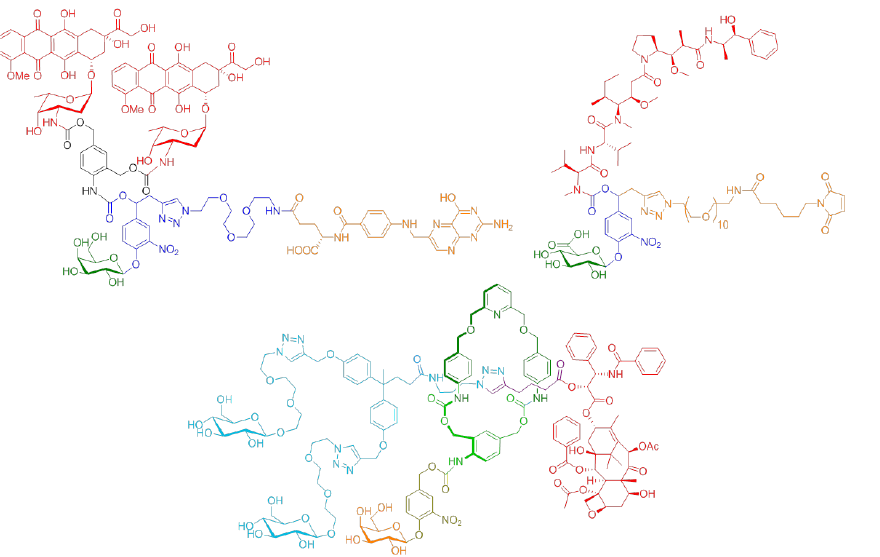
Figure 2. Self-immolative platforms.